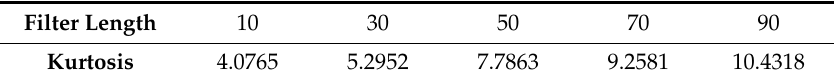
Table 1. The kurtosis value corresponding to different filter lengths.